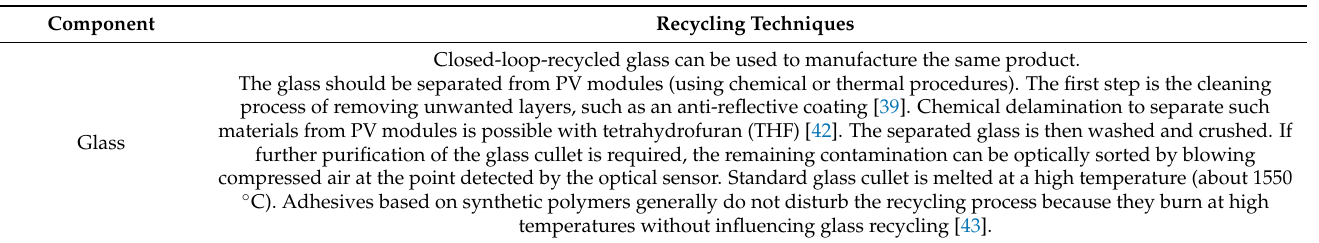
Table 1. Recycling techniques for particular components of solar